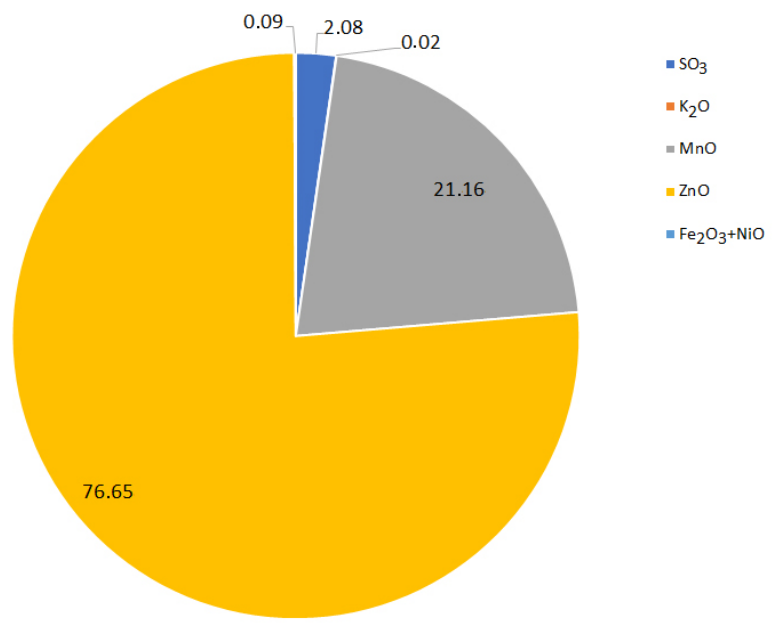
Figure 20. Chemical composition (wt.%) of zinc precipitate as a result of precipitation by using H 2 SO 4 from solution after manganese precipitation.